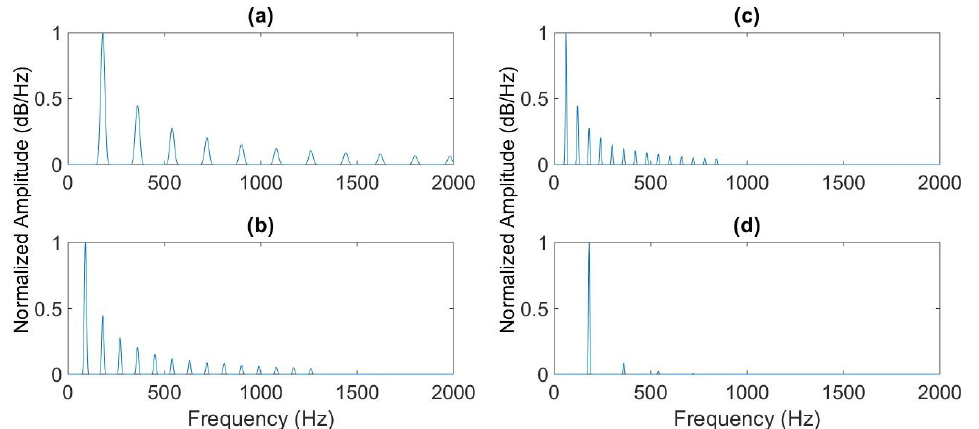
Figure 8. Part of the spectrum of the simulated drone signal ( a ), first ( b ) and second ( c ) compressions of this spectrum, and the product of the three spectra ( d